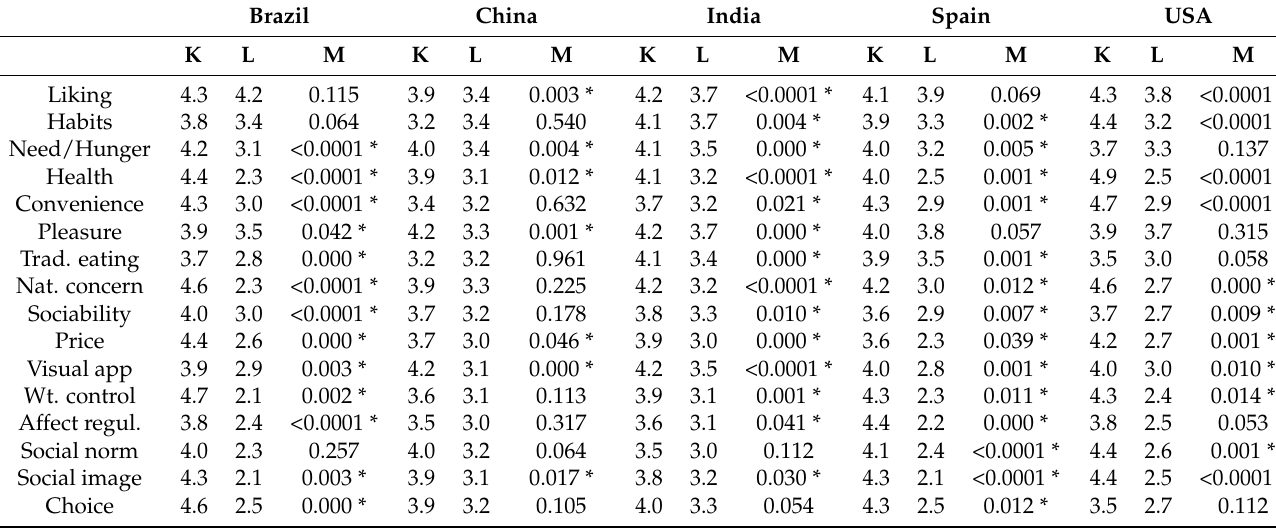
Table A12. Mean scores1 for RATA and RATING survey formats and p -values for the corresponding two-sample t -test for each motivation construct for dessert foods in all five